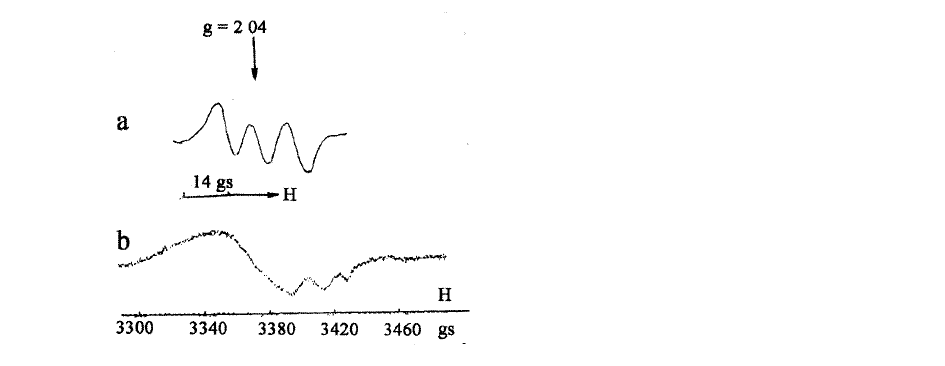
Figure 8. EPR signals of MNICs with cysteine detected at the initial stage of the reaction between divalent iron, NO and cysteine, resulting in formation of DNICs with cysteine. MNICs appeared in the solution of Fe 2+ (5 mM) and cysteine (25 mM) after treatment with gaseous NO at the pressure of 20 torr for one minute. Recordings were made at ambient temperature ( a ) or at 77K ( b ) [79].